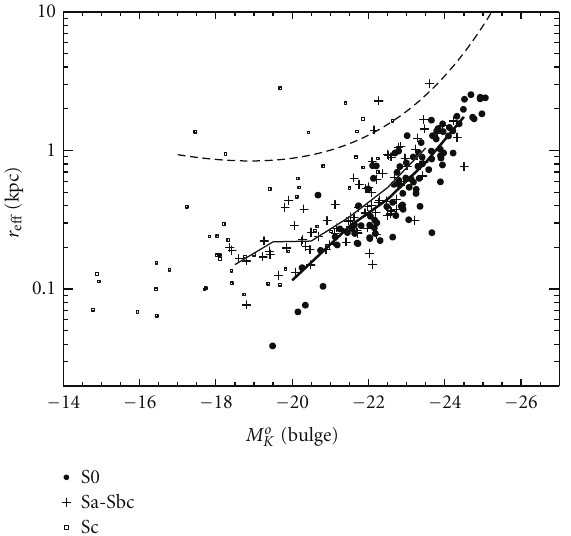
Figure 10: The e ff ective radius of the bulge ( r e ff ) plotted against (bulge)). Shown separately the absolute brightness of the bulge ( M o K are S0s (filled symbols), Sa-Sbc spirals (crosses), and Sc and later types (squares). The dashed line shows the location of the elliptical galaxies, taken from Graham and Worley [64]. The continuous lines show the mean values of the data points in one magnitude bins: the thick line is for the S0s and the thin line for the Sab-Sbc spirals. This figure is part of Figure 8(a) in Laurikainen et al.